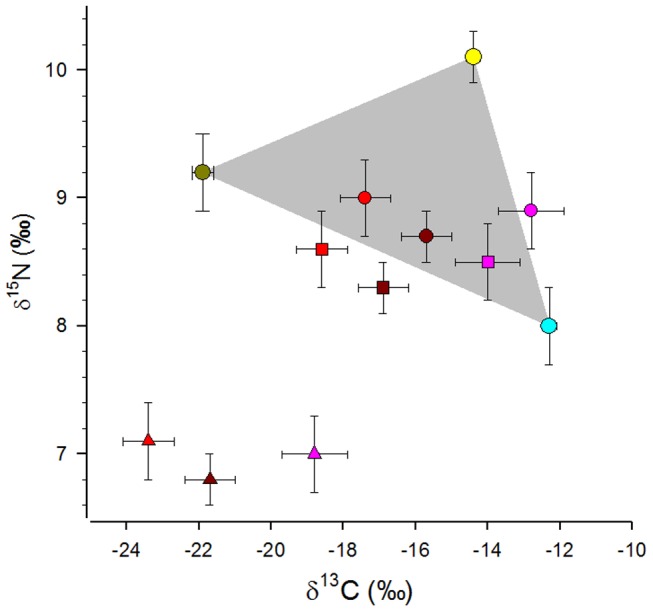
Nitrogen isotope ratios (δ15N; mean ± standard error, ‰) in relation to stable carbon isotope ratios (δ13C; ‰) in the three prey categories (browser: green circle, grazers with high δ15N: yellow; grazers with low δ15N: blue) and in three categories of cheetahs (note that isotopic data of cheetahs were corrected for trophic discrimination): females (red symbols), solitary males (dark red) and males in bachelor groups (pink).The grey zone indicates the isoscape covered by the mean values of prey categories. We assessed the sensitivity of the model output based on 3 scenarios with suggested trophic discriminations. (1) trophic discrimination established by this study (circles), (2) by Roth and Hobson [39] (squares) and (3) by Parng and coauthors [40] for felid species (triangles).